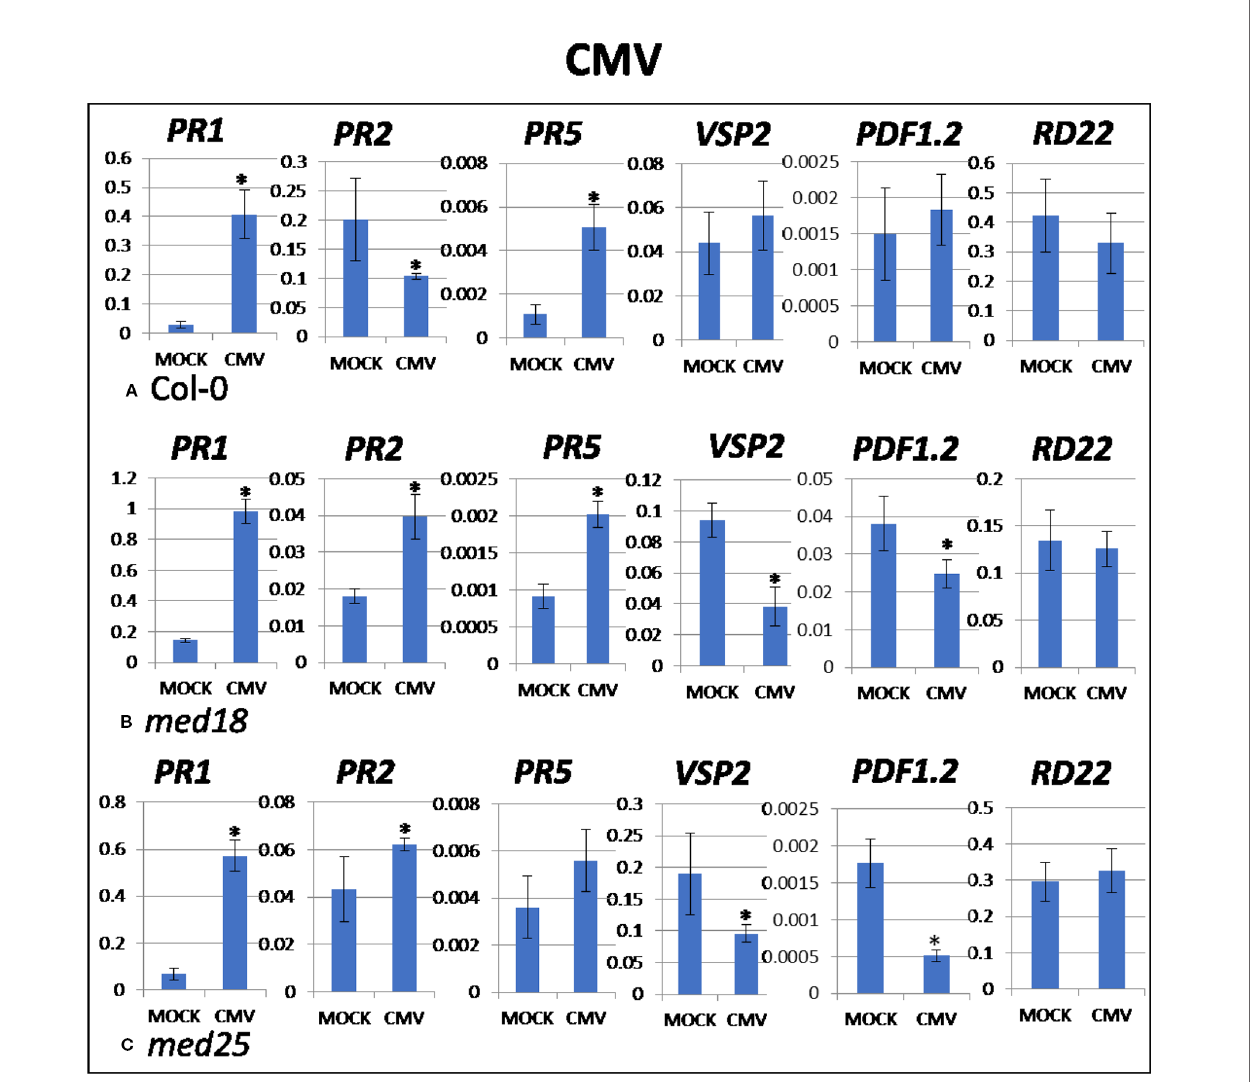
FIGURE 5 | Quantitative reverse transcriptase PCR (qRT-PCR) assays with SA- ( PR1, PR5 ), JA- ( PDF1.2, VSP2 ), and ABA- ( RD22 ) signaling marker genes of Arabidopsis plants inoculated with CMV. Shown on the Y axes are mean ± SE values of transcript abundances relative to ACTIN housekeeping genes for wild-type (A) Col -0, (B) med18 , and (C) med25 plants at 2 days after inoculation. Asterisks indicate signi fi cant ( P < 0.05) induction or repression of each gene by comparing the means of mock-inoculated to CMV-infected